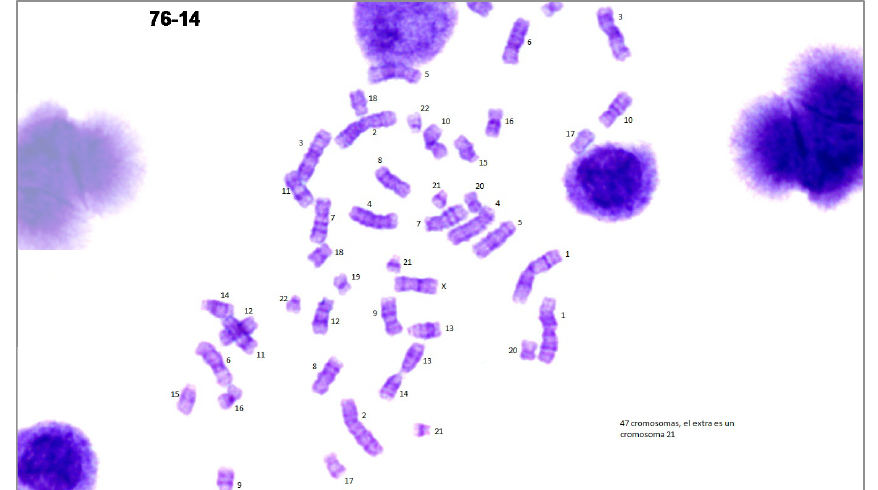
Figure 1. Manual karyotype labeling performed by an expert cytogeneticist over an image obtained with the G-banding technique.